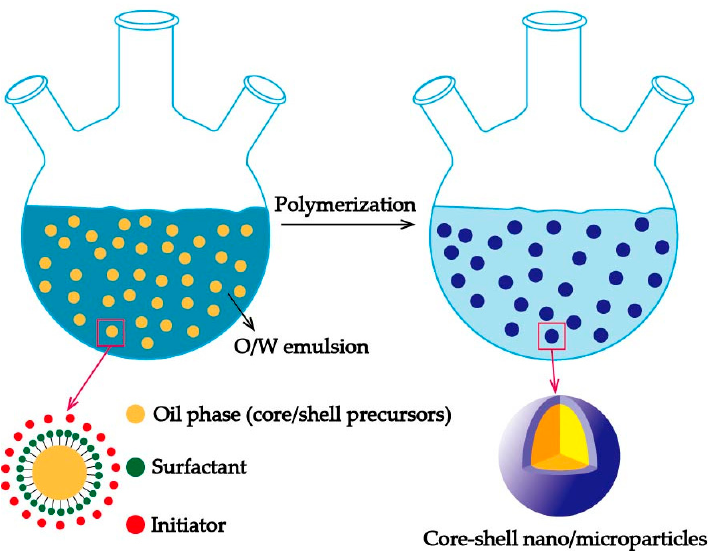
Figure 3. Schematic representation of the oil in water (O/W) emulsion polymerization.